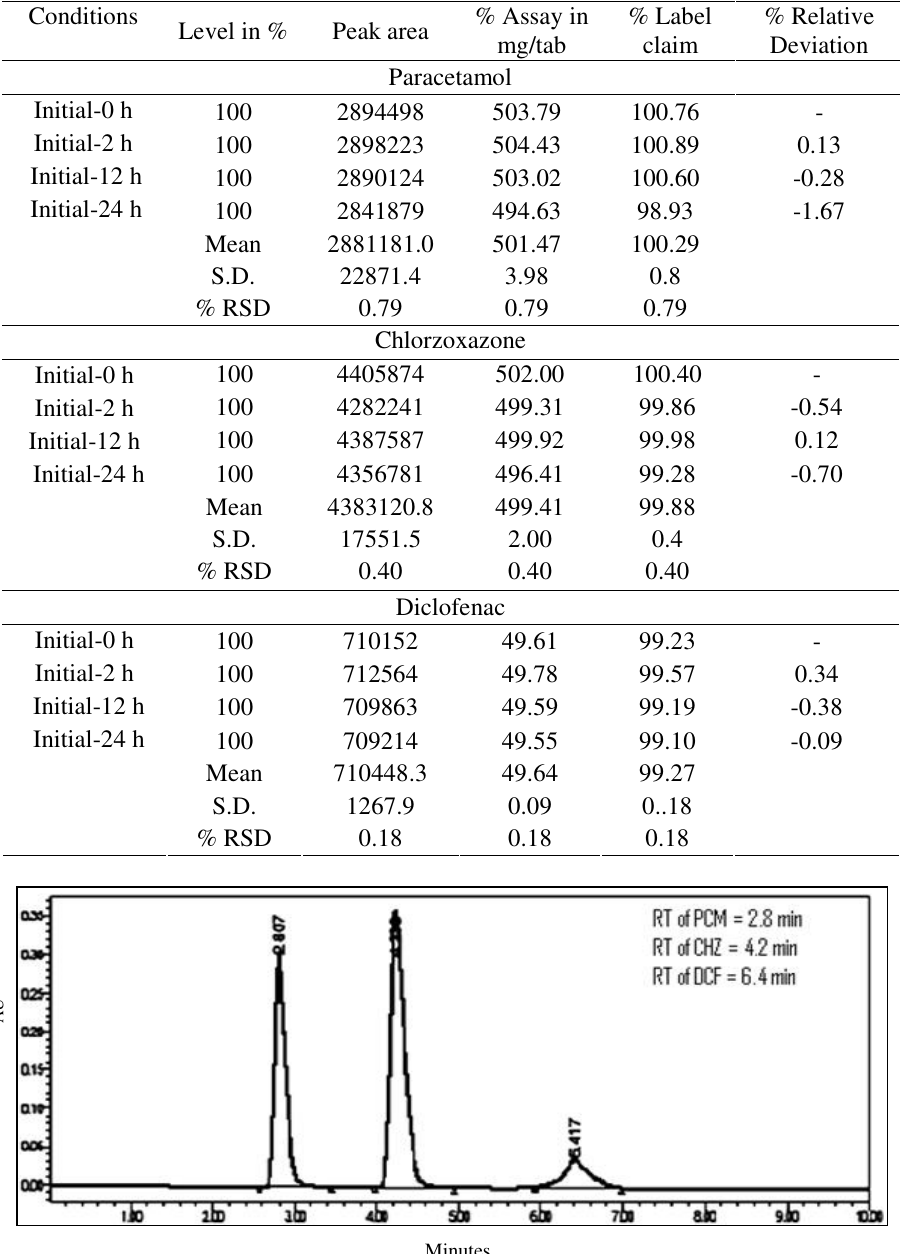
Figure 2. Chromatogram of paracetamol, chlorzoxazone and diclofenac sodium in 100% sample